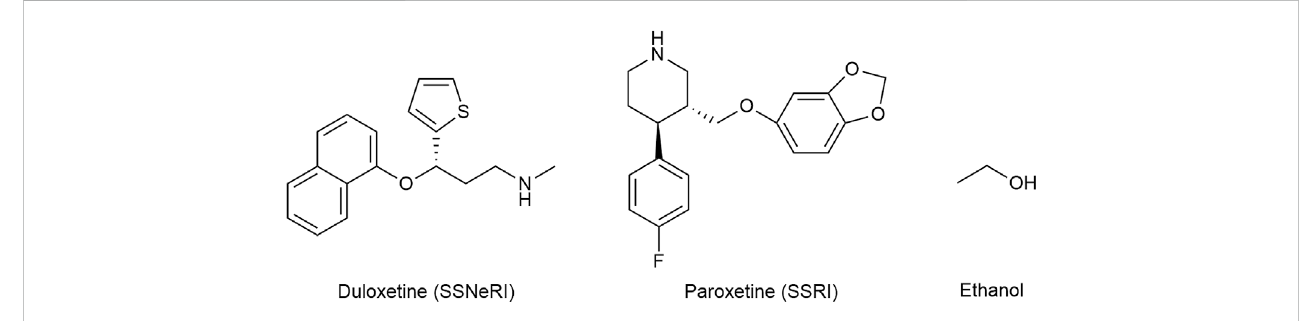
FIGURE 8 The structures of duloxetine (selective serotonin and norepinephrine reuptake inhibitor — SSNeRI), paroxetine (selective serotonin reuptake inhibitor — SSRI), and